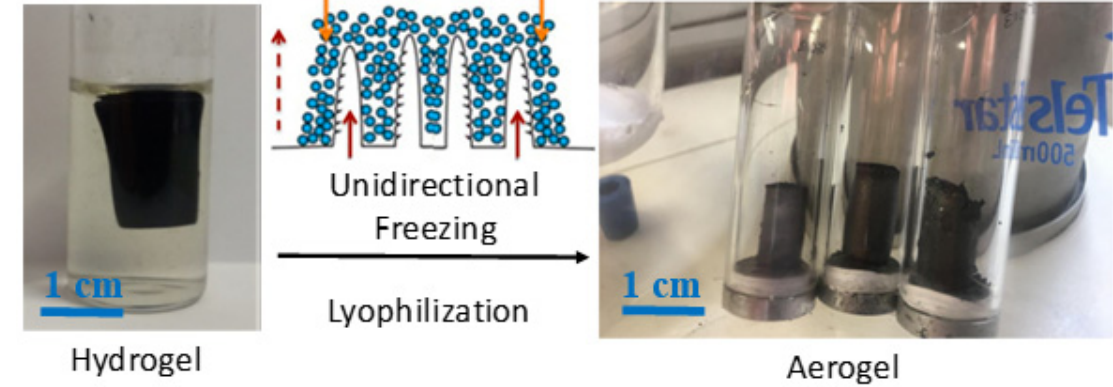
Figure 10. Real images of a hydrogel derived from hydrothermal treatment in water (left) and preparation scheme of aerogels by unidirectional freezing followed by lyophilization (right).